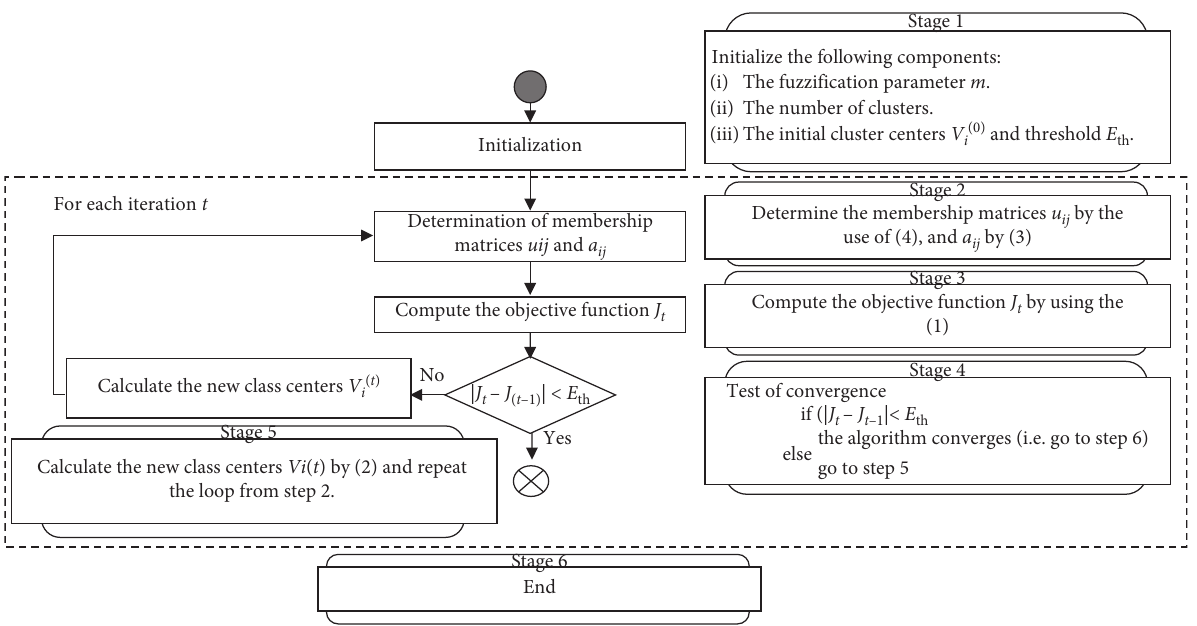
Figure 2: Standard type-2 Fuzzy logic algorithm’s